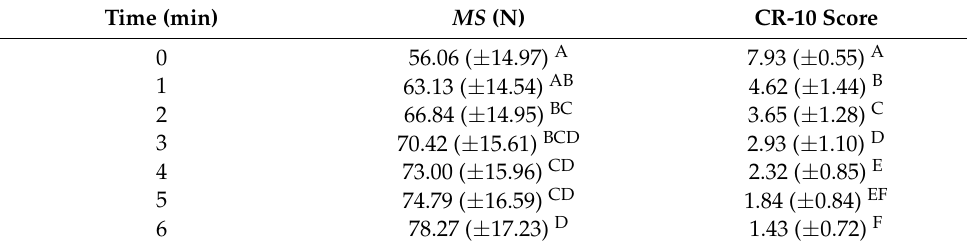
Table 4. Bonferroni post hoc test results of MS and CR-10